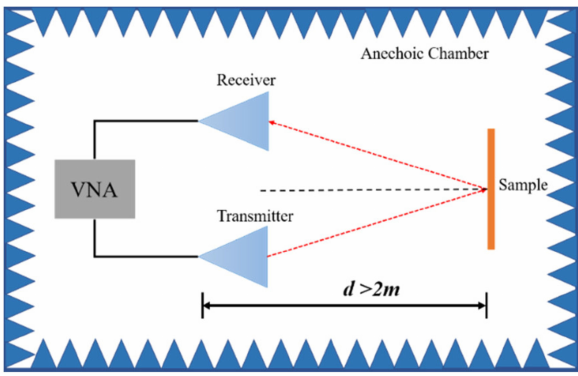
Figure 11. Schematic diagram of measured device and environment.